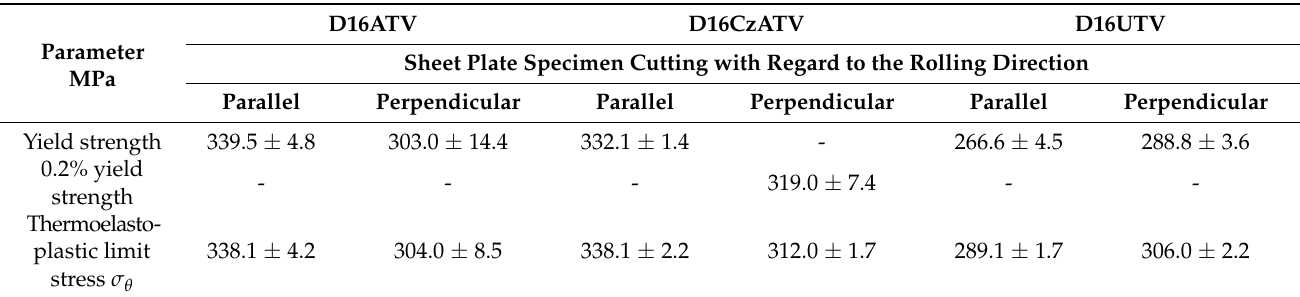
Table 11. A summary of the yield strength and the thermoelasto-plastic limit stress values for sheet plate made of the D16 aluminum alloy depending on the thickness and the rolling direction.